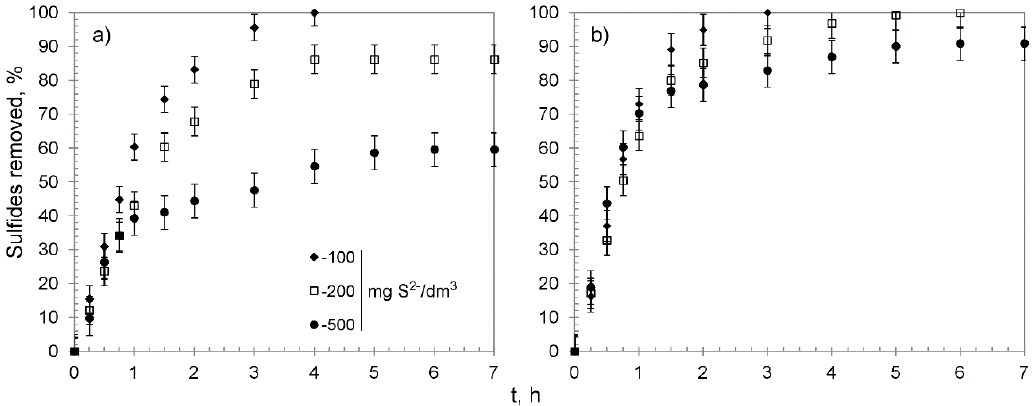
Figure 6. Sulfide removal effectiveness of hybrid materials versus time: ( a ) CWM1#MnO 2 , ( b ) CWM3#MnO 2 ; on average, n =